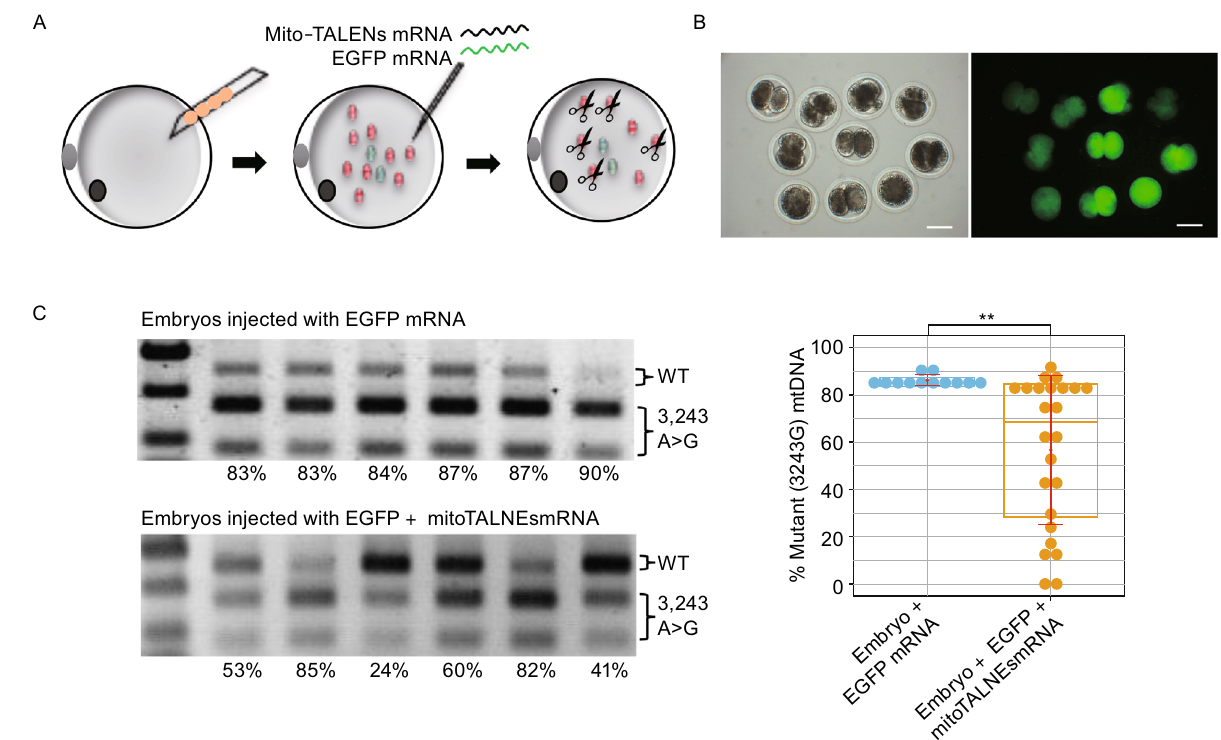
Figure 6. Speci fi c targeting of human mutant mtDNA in porcine oocytes using MitoTALENs. (A) Construction of porcine oocytes carrying human m.3243G>A mutations by injection of the cytoplasm of MiPSCs into porcine MII oocytes, followed by injection of EGFP and mitoTALENs mRNA targeting the 3243G mutant mtDNA. (B) Expression of EGFP in arti fi cial porcine oocytes 48 h after injection of mRNA. (C) RFLP analysis and quanti fi cation of m.3243A>G heteroplasmy in individual oocytes 3 days after